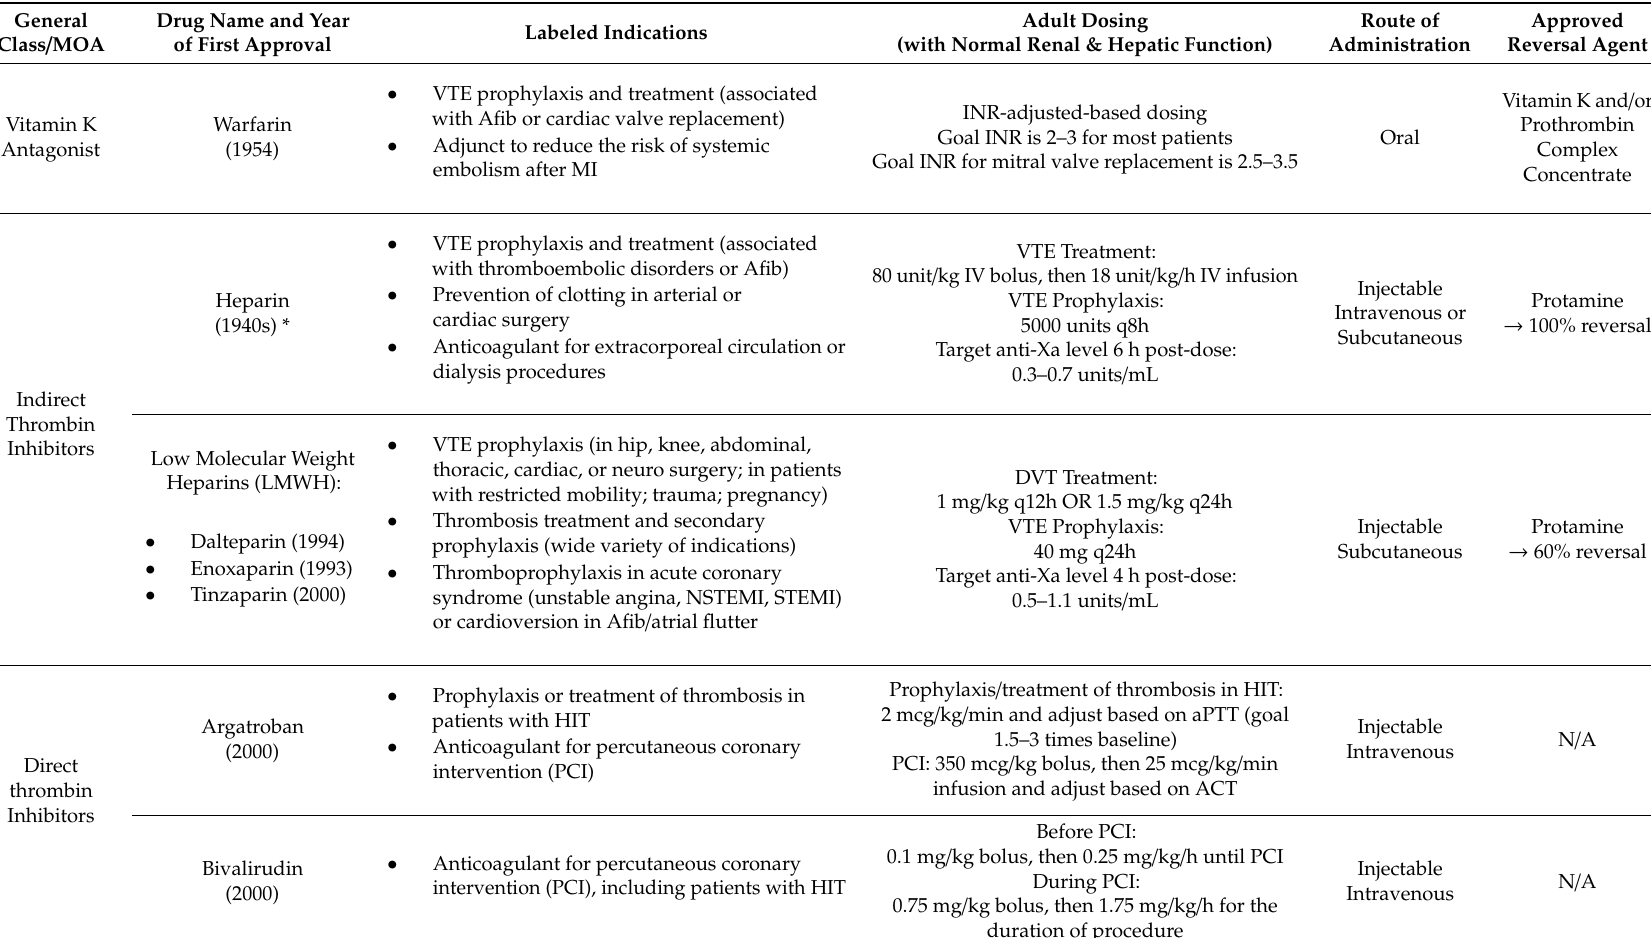
Table 1. Overview of available anticoagulant